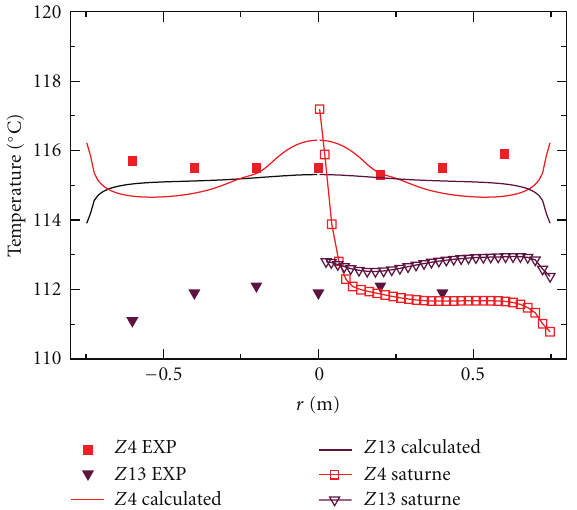
Figure 8: Radial profile of the gas temperature at Z 4 = 1 . 47 m and Z 13 = 3 . 93 m: steady state 1.